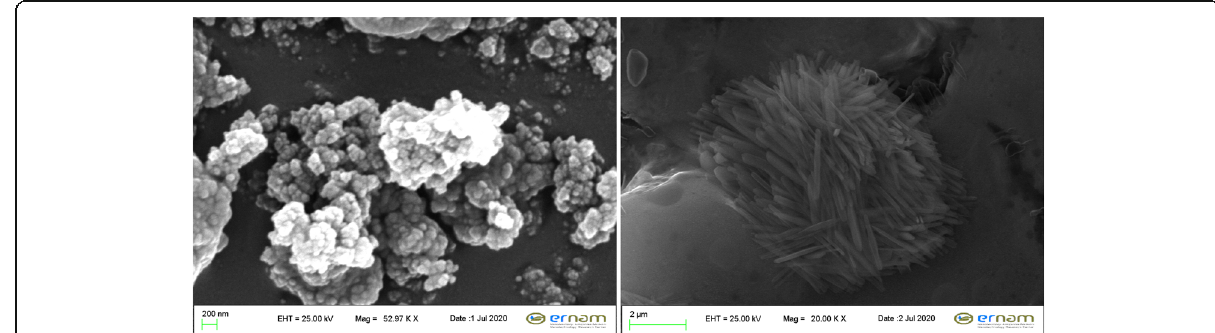
Fig. 4 Scanning electron micrograph of the prepared from decanoic acid/THF (200 mg/600 μ L) at pH 3.0 (10 mM). Length of the bars are 200 nm and 2 μ m respectively.